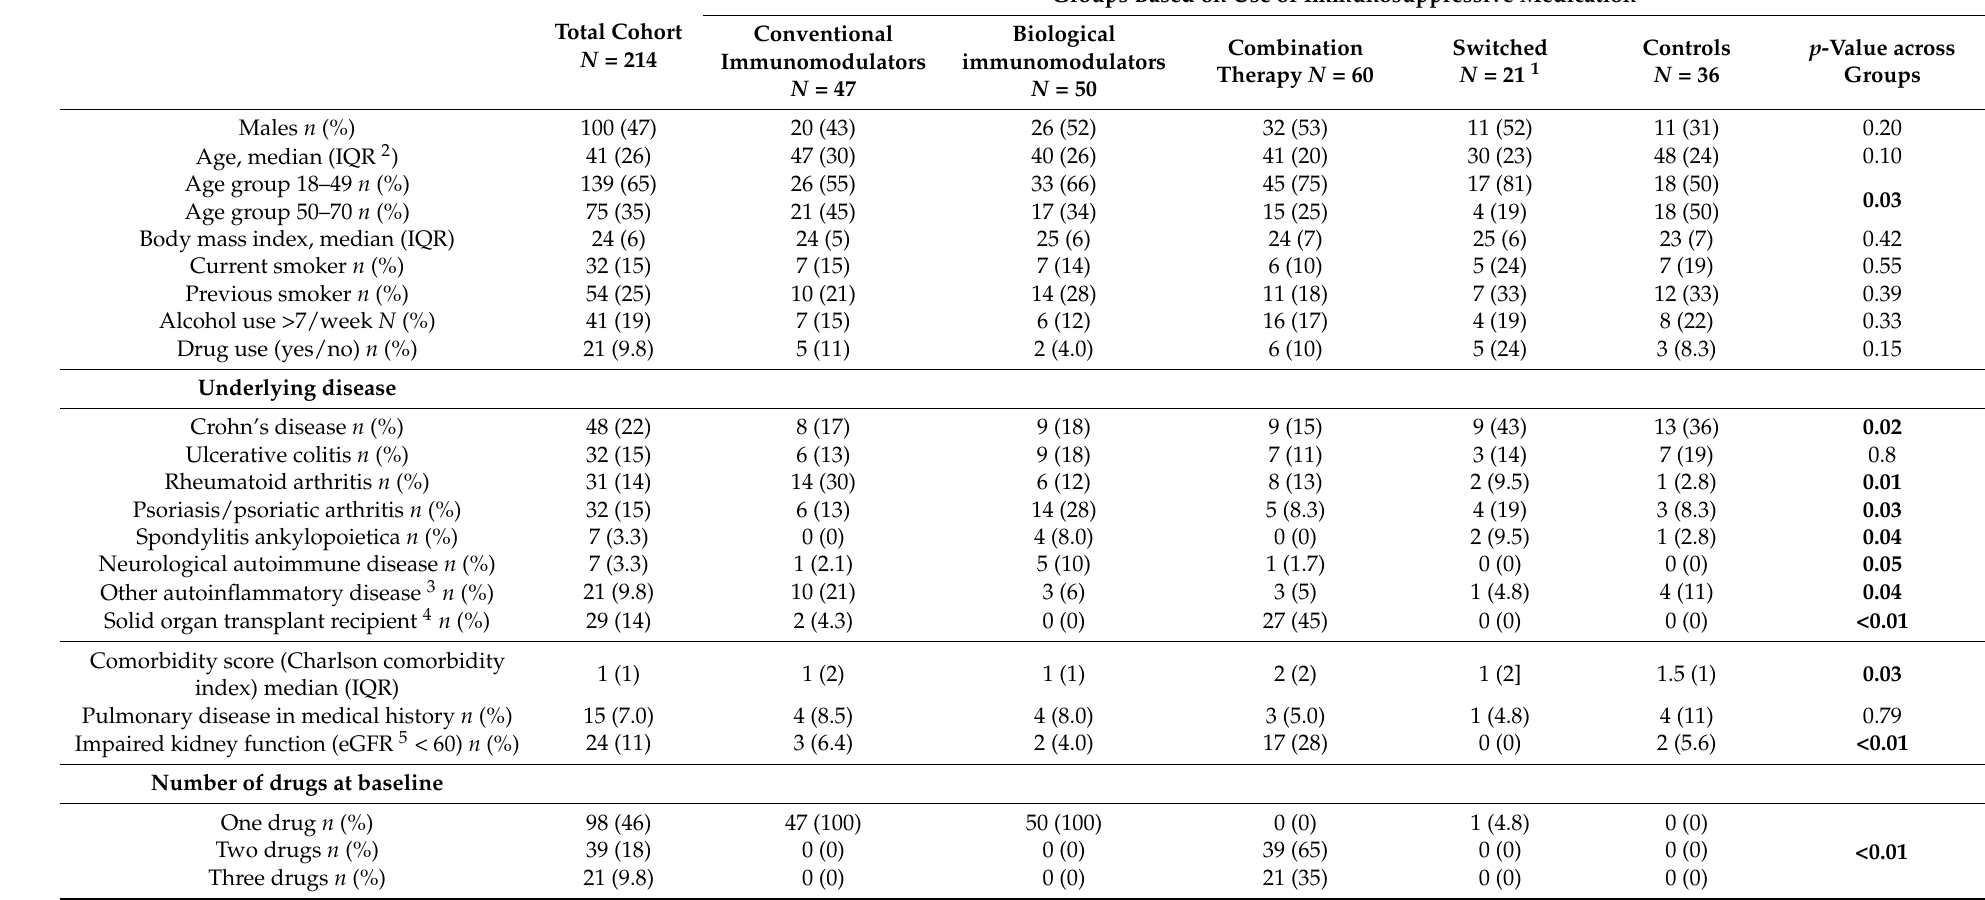
Table 1. Baseline